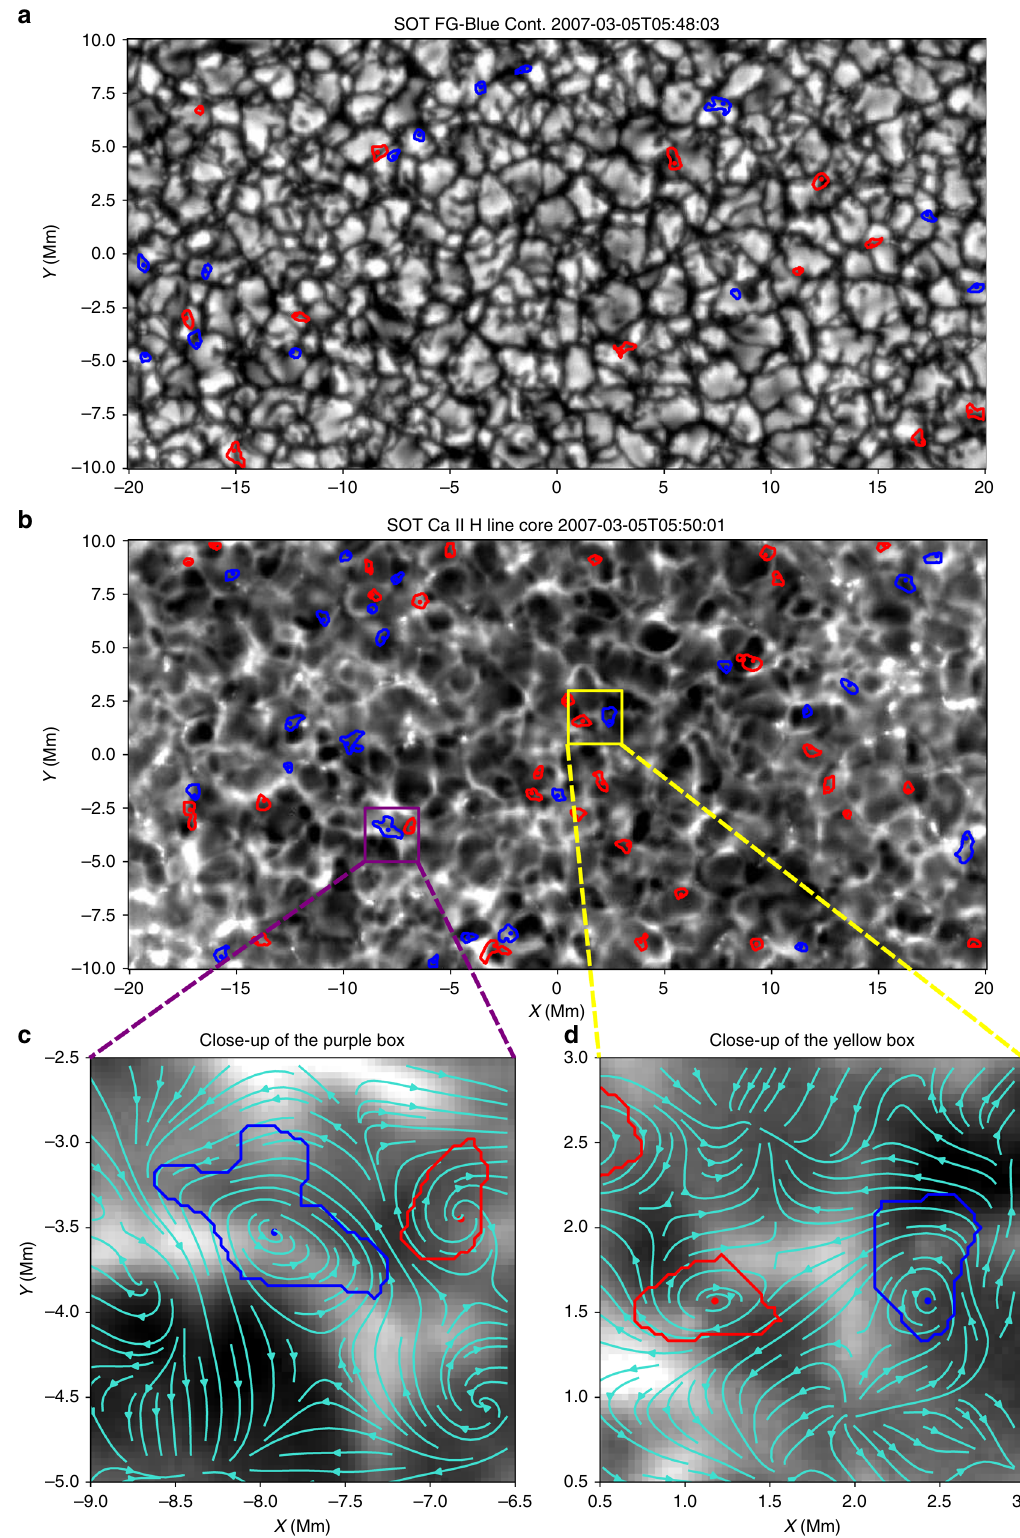
Fig. 1 Photospheric and chromospheric swirls detected by ASDA using SOT observations. The observed intensity is shown as the white-black background in all panels. Photospheric intensity swirls ( a ) detected at 05:48:03 UT were found to be best correlated with chromospheric swirls ( b ) detected 118 s later (05:50:01 UT). Swirls, with positive (negative) rotating direction are denoted in blue (red). Contours and dots are their edges and centres, respectively. Turquoise arrows in c , d represent the tracked velocity fi eld by the FLCT method 25,26 . The analysed data contain a series of photospheric and chromospheric observations in a quiet region close to the disk centre. Source data are provided in the Source Data fi le